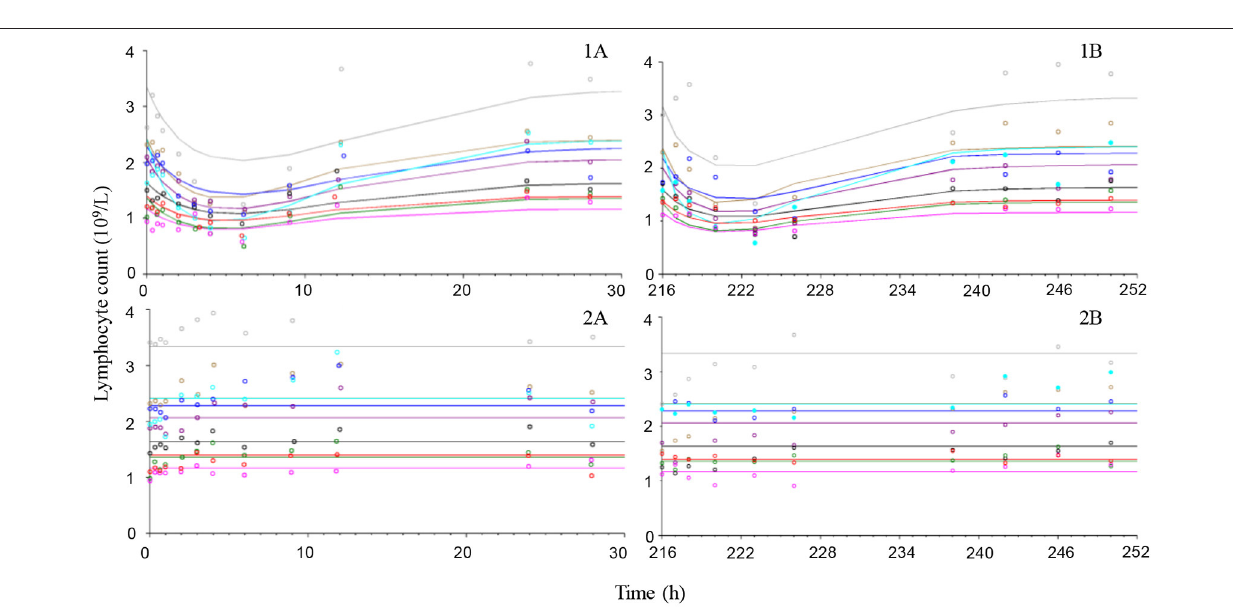
FIGURE 5 | Observed (symbols) and model predicted (lines) lymphocyte count-time courses following intravenous administration (left plots) of 1 mg/kg prednisolone succinate (1A) or saline (2A) and after the last oral (right plots) dose (216h after first dose) of ∼ 1 mg/kg for 10 consecutive daily doses orally (1B) or placebo (2B) to 9 beagle